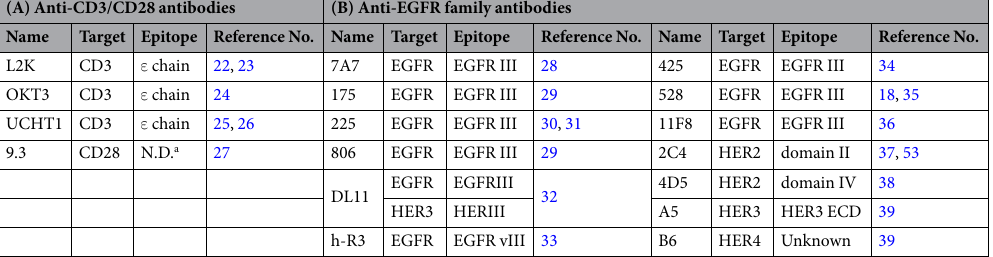
Table 1. Antibodies used to construct diabodies. a N.D.: Not